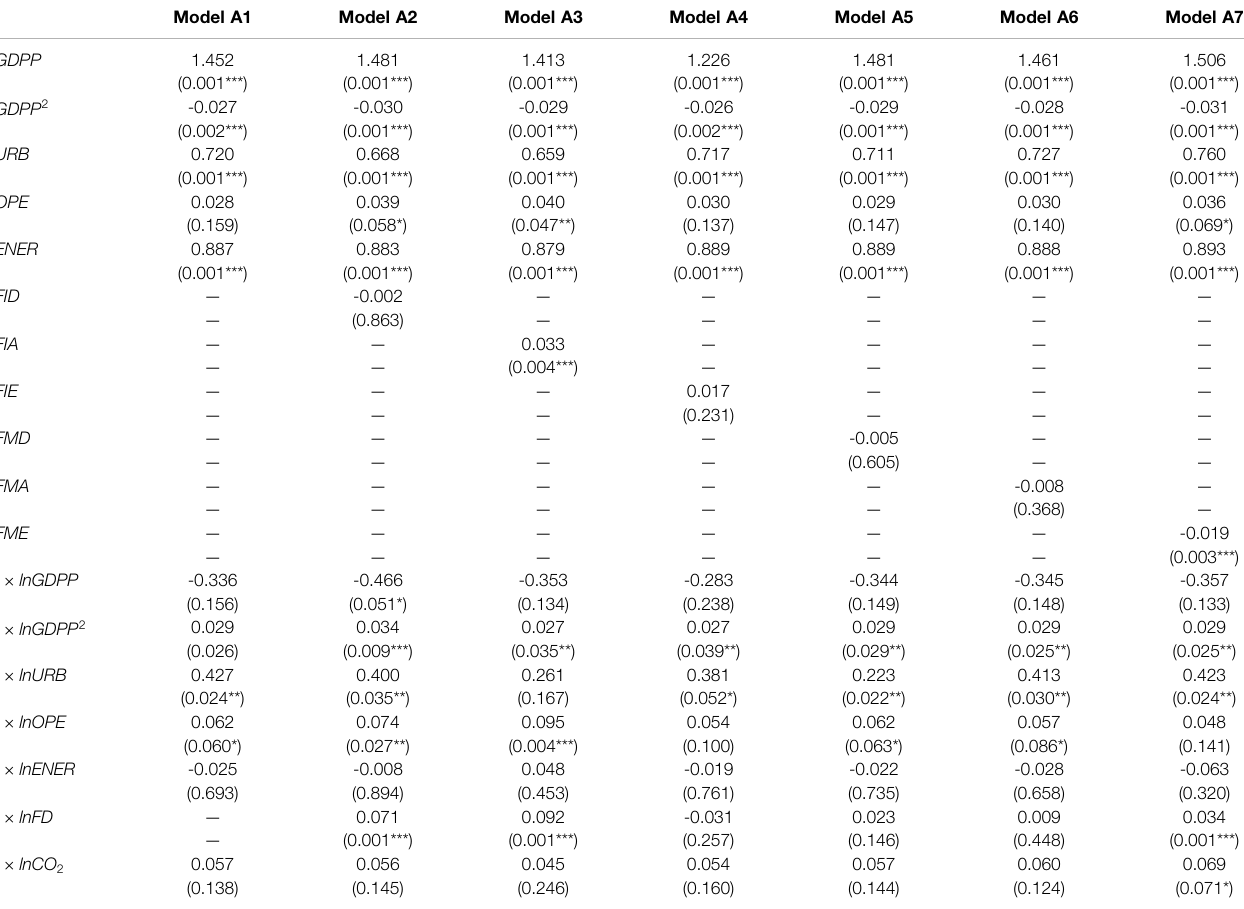
TABLE 8 | Results of the estimation of Equation